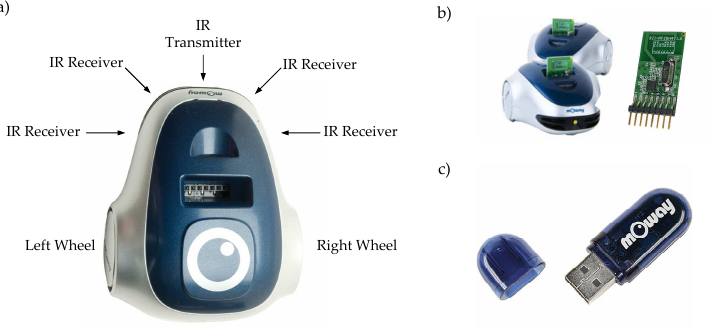
Figure 8. Robot platform: ( a ) components and sensor distribution; ( b ) robot wireless interface; and ( c ) PC wireless